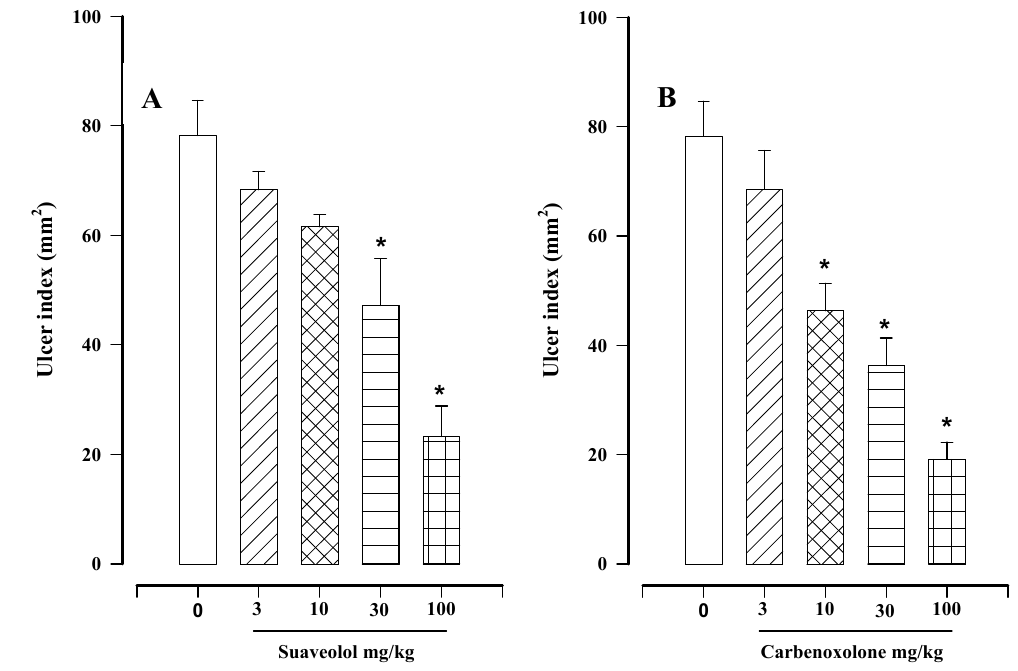
Figure 2. Effect of different doses of ( A ) suaveolol (3–100 mg/kg) and ( B ) carbenoxolone (3–100 mg/kg) on gastric lesions induced in rats by absolute ethanol. Bars represent the mean ± SEM, n = 8. * p  0.05 vs. the respective control; Dunn’s multiple comparison test after the Kruskal-Wallis